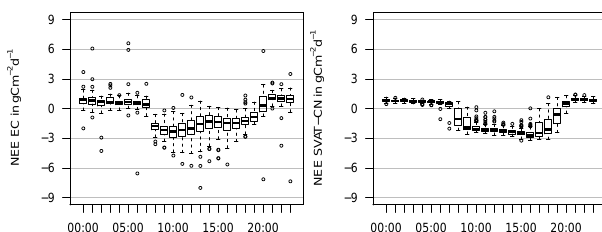
Figure B5. Mean diel course of measured (left panel) and modelled (right panel) net ecosystem exchange (NEE) over 44 days during 2009 (26 June to 8 August) at Nam Co: box plot with median, 25 and 75% quartiles; bars represent quartiles ± 1.5 times interquartile range, dots are outliers. Measured and modelled values are restricted to high data quality (flag 1–3 out of a scheme ranging from 1 to 9, Foken et al., 2004). Model parameters for leaf physiology and soil respiration were adapted for best representation of eddy-covariance data (see Sect.